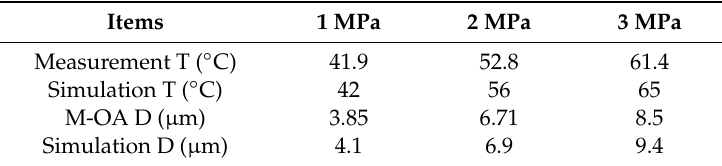
Table 3. Temperature and deformation results at 60 min.